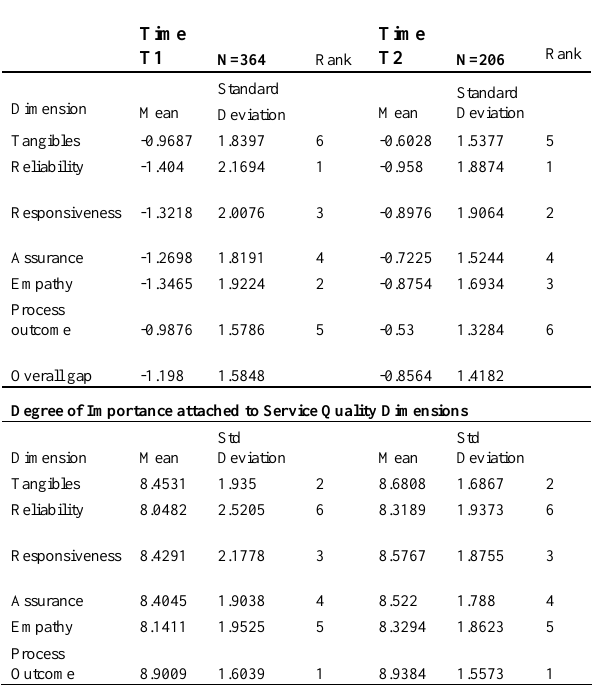
Table 3: Students’ aggregated gaps scores and importance attached to service quality dimensions at between time T1 and time